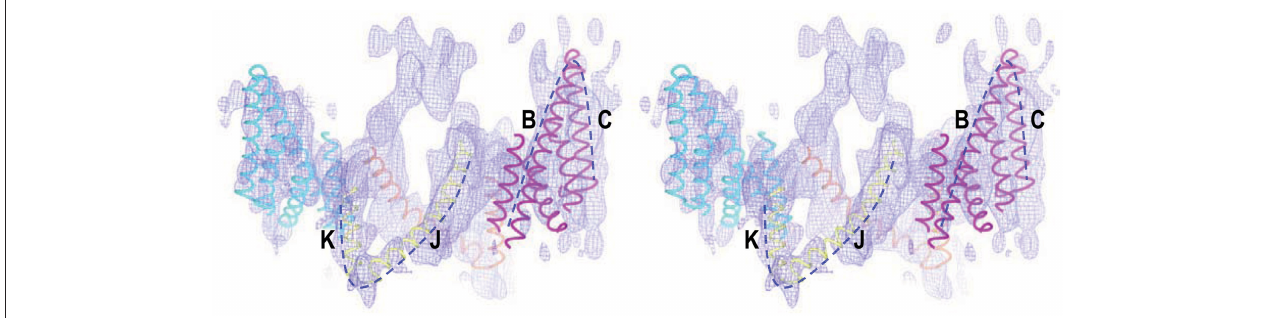
FIGURE 4 | Stereo view of cryo-EM structure of the TMD of human AE1 fitted with structural elements of chloride channel ClC. The dotted lines show the two V-shaped structures in the TMD of AE1 that fit well with helices B + C and J + K of ClC, respectively. The figure was modified from Yamaguchi et al. (2010b) with